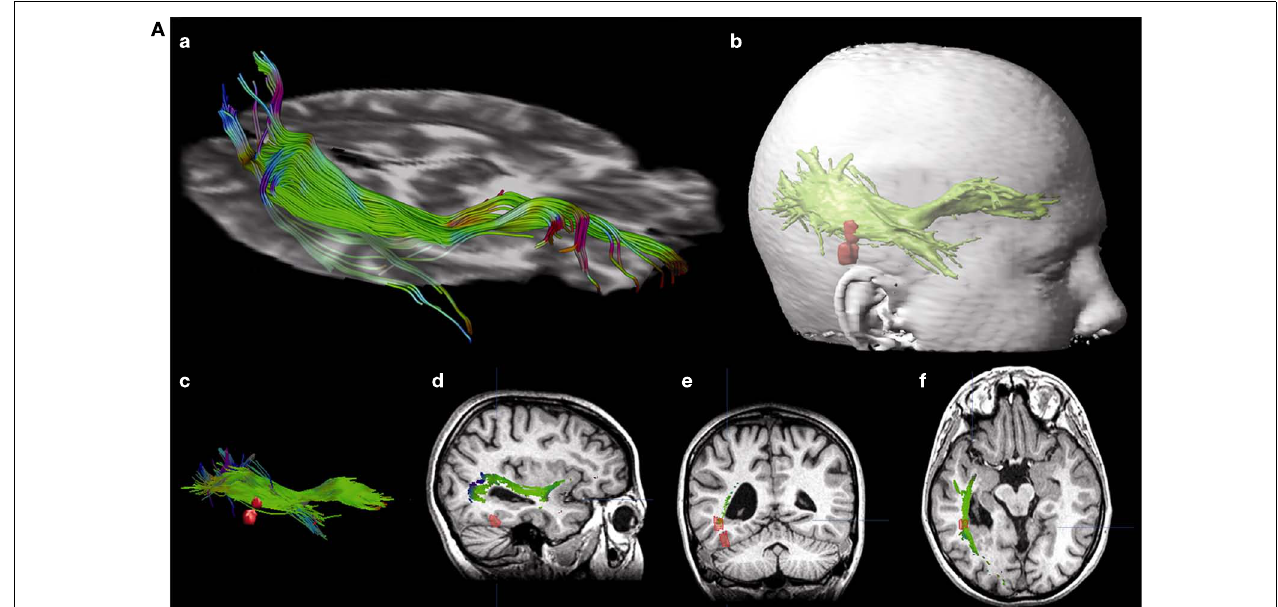
as streamlines) to MSI foci. (d–f) Sagittal/coronal/axial view ofT1-weighted images with registered DTI and MSI data. Localization of focal epileptic activity is below the opticTract (Stefan et al.,